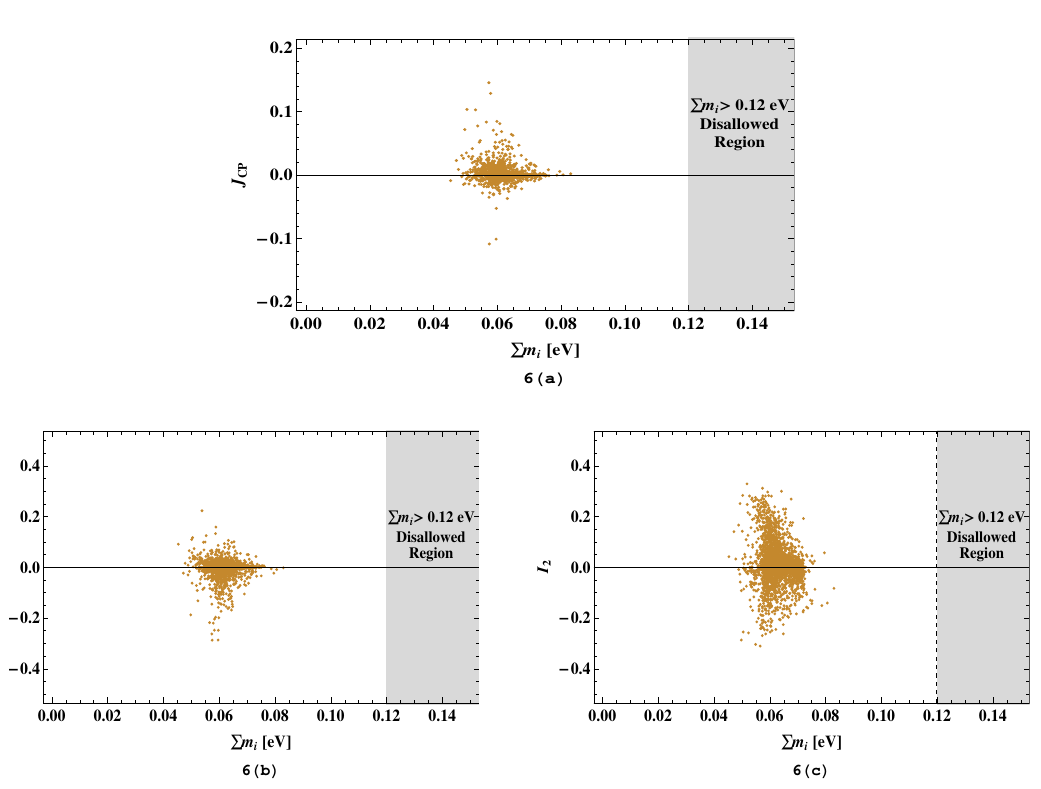
Figure 6 . Variation of CP invariants J CP , I 1 and I 2 with sum of neutrino masses P m i